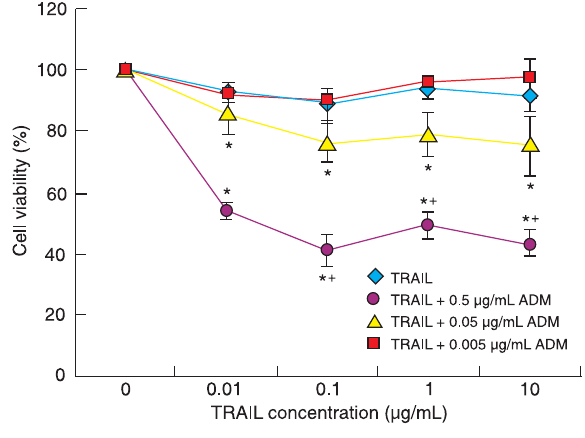
Figure 1. Effect of TRAIL or ADM alone on cell viability of human breast cancer MCF-7 cells. Panel A , TRAIL; panel B , ADM. MCF-7 cells were incubated with TRAIL (from 0 to 100 µg/mL) or ADM (from 0 to 50 µg/mL) for 24 h. Cell viability was evaluated by the MTT assay. TRAIL = tumor necrosis factor-related apoptosis-inducing ligand; ADM = adriamycin; MTT = 3-(4,5-dimethylthiazol-2-yl)-2,5- diphenyltetrazolium bromide. Data are reported as means ± SD of representative experiments. * P < 0.05 compared to other concen- trations of TRAIL; + P < 0.05 compared to 0, 0.0005, 0.005, 0.05 µg/mL ADM; # P < 0.05 compared to other concentrations of ADM (Student t -test).